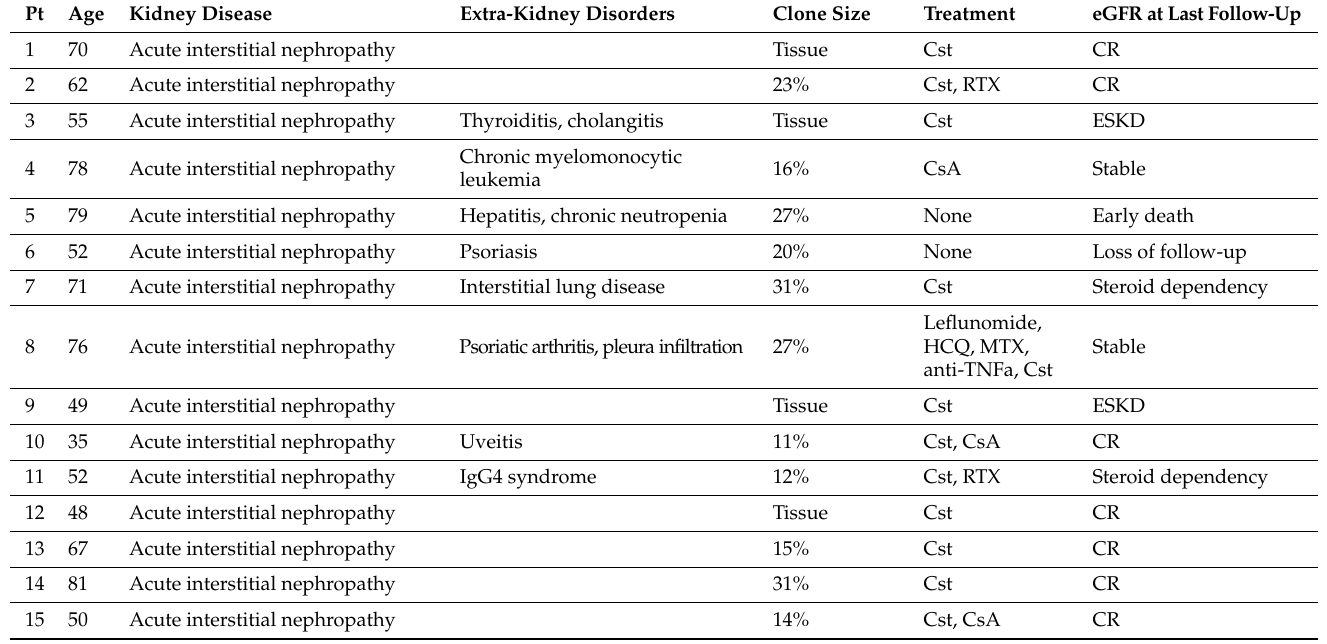
Table 1. Characteristics of the 29 patients with TIC and kidney involvement.